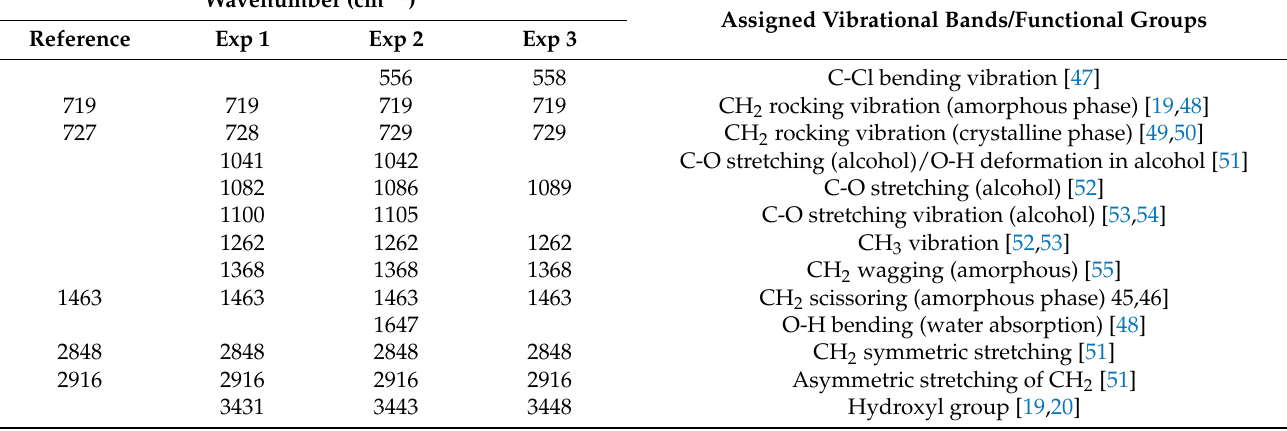
Table 4. Spectral bands for virgin and aged samples.